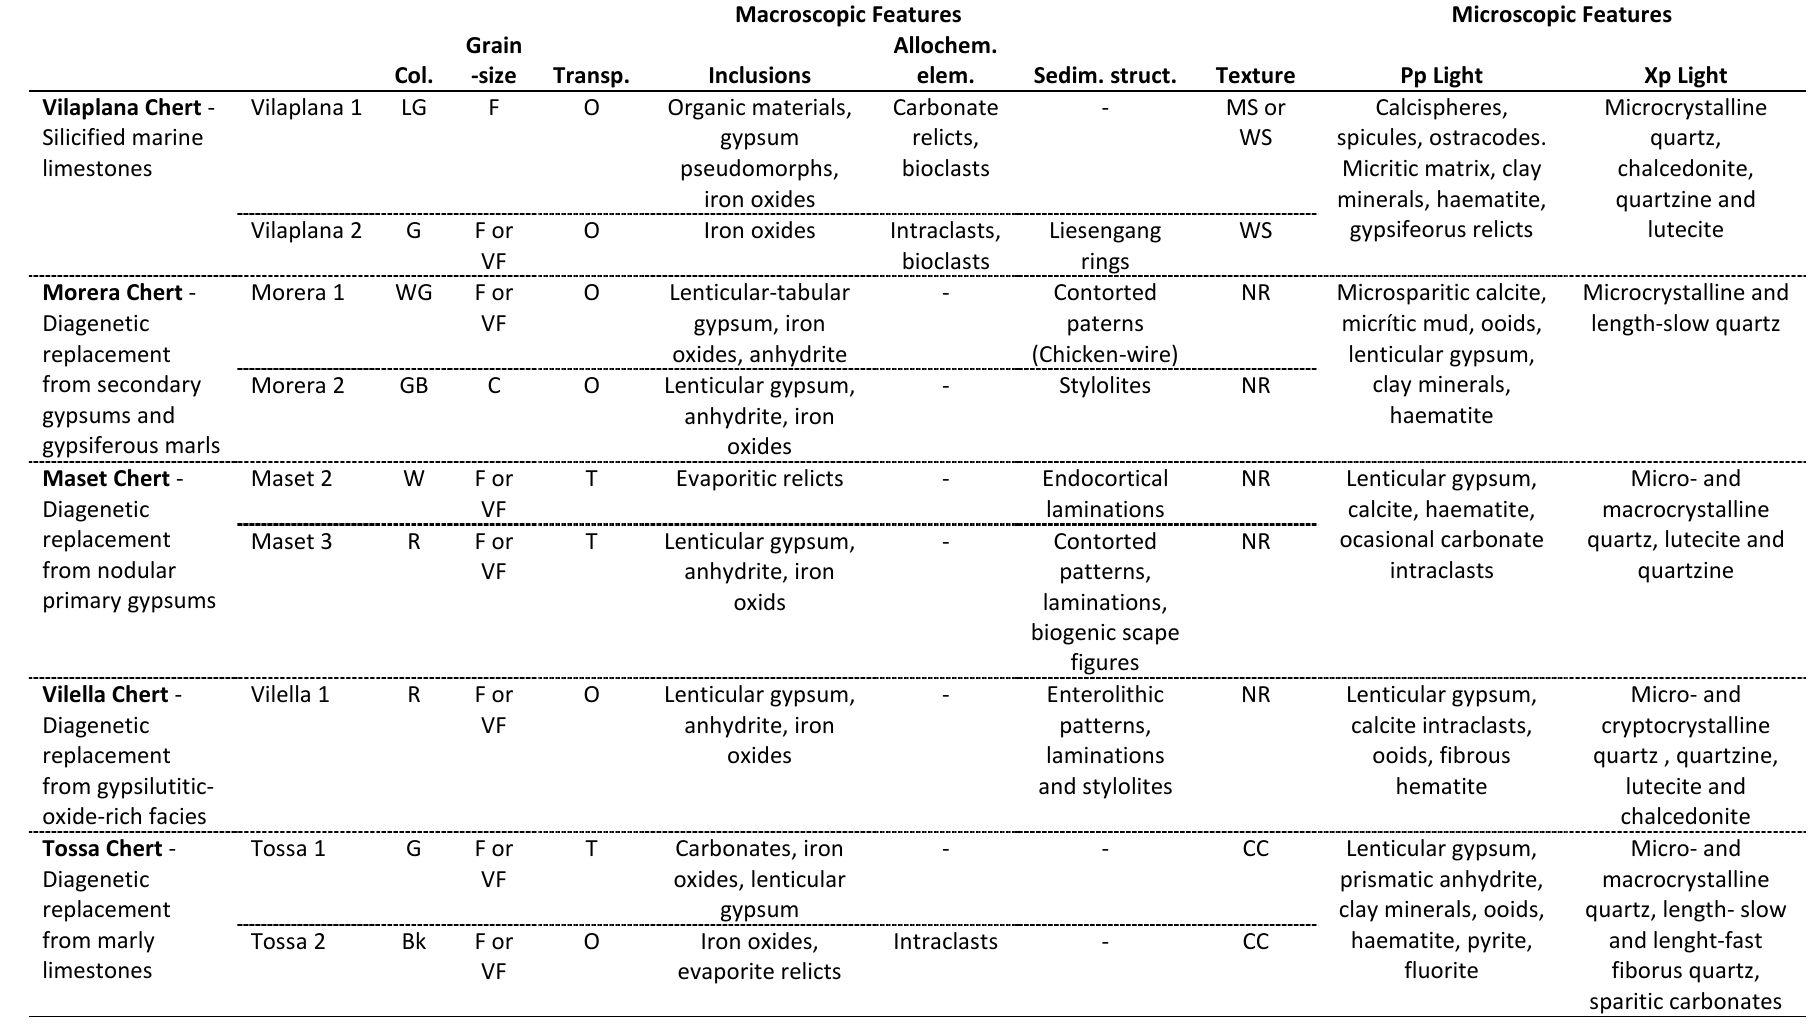
Table 2. Main characteristics of the chert varieties identified. Abbreviations: Col. - colour ; LG - light grey; G - grey; WG - white-grey; GB - grey-blue; W - white; R - red; Bk - black; F - fine; VF - very fine; C - coarse; Transp. - transparency; O - opaque; T - translucent; Allochem. elem. - allochemical elements; Sedim. struct. - sedimentary structure; MS - mudstone; WS - wackestone; CC - crystalline carbonates; NR -